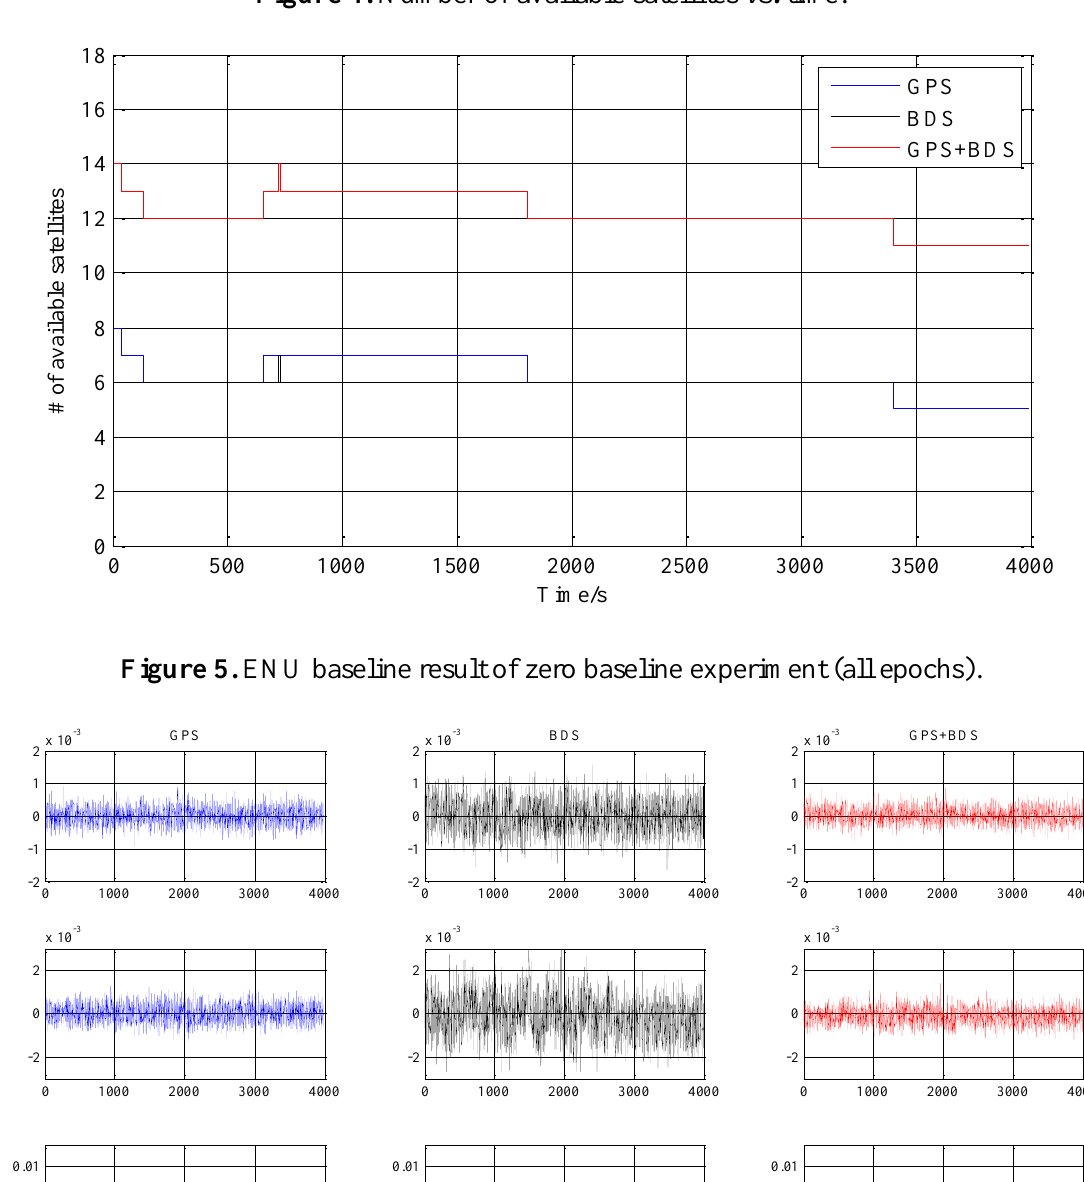
Figure 4. Number of available satellites vs. time.